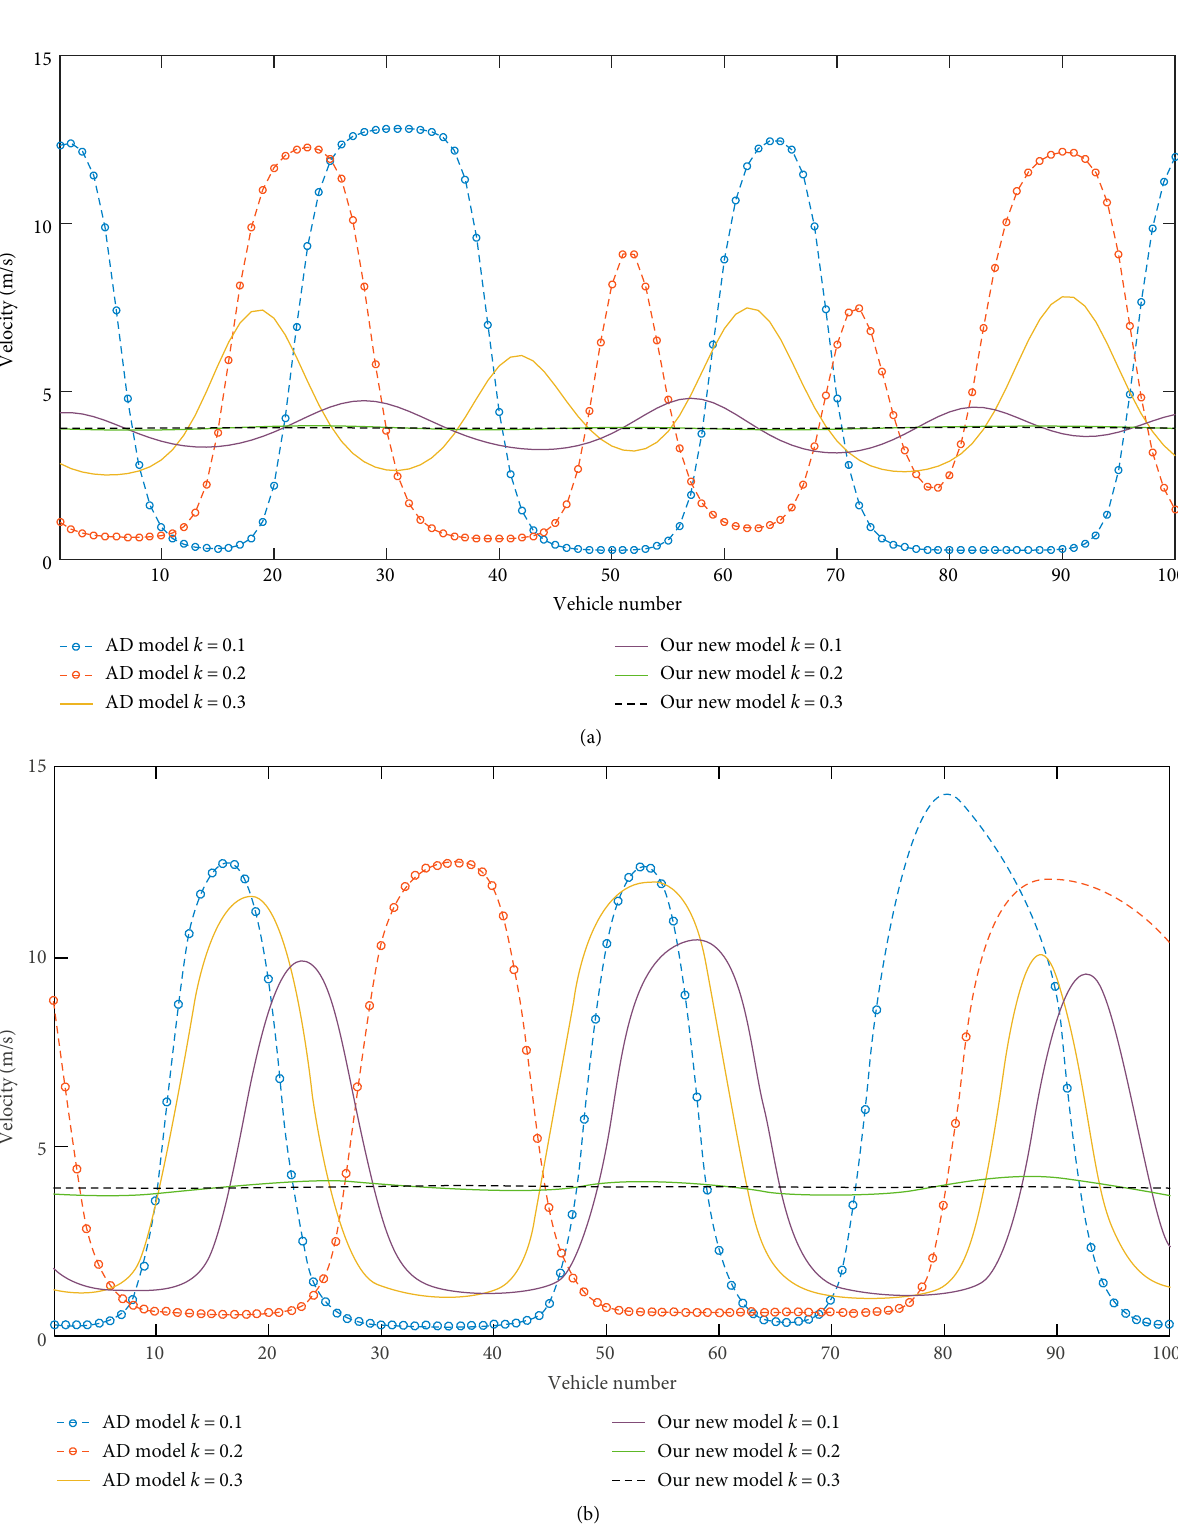
( in the AMD model). 𝑘 𝑚 = 1